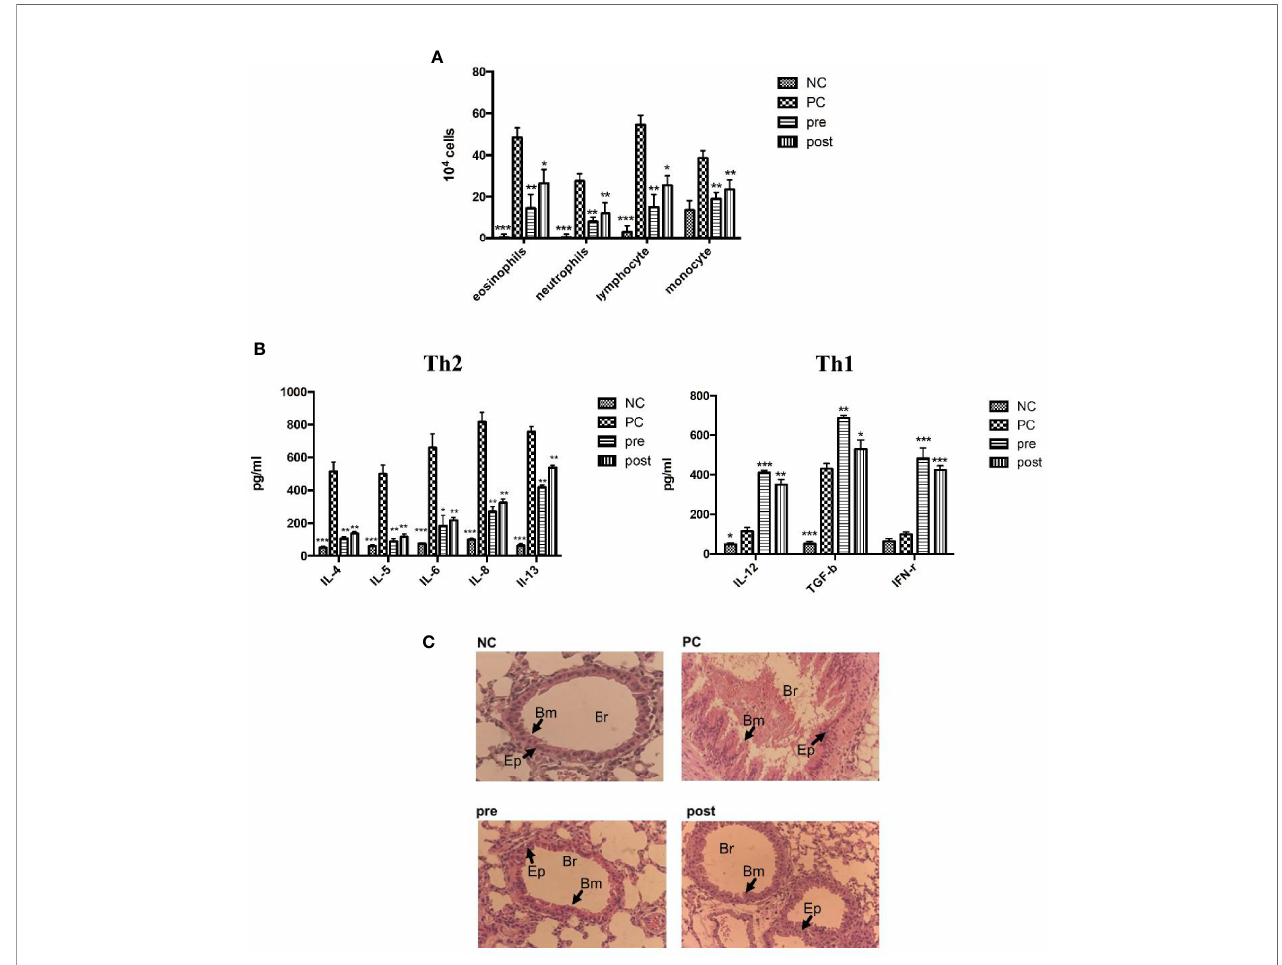
FIGURE 7 | The effects of FIP- fve treatment on the in fi ltrating in fl ammatory cells and cytokines in the BALF and the airway in fl ammation of Der m 2 -sensitized mice. (A) The in fl ammatory cells in the BALF of Der m 2 -sensitized mice were shown, and the total cells and in fl ammatory cells were counted (×10 4 ) from the BALF in millimeters by morphometric evaluations of cytospin preparations. (B) The different cytokine sets represent the Th1- and Th2-type responses. Th2-type cytokines were IL-4, IL-5, IL-6, IL-8, and IL-13 in the left panel, and Th1-type cytokines were IL-12, TGF- b , and IFN- g in the right panel. *** P < 0.001, ** P < 0.01, and * P < 0.05 compared with PC. (C) Histopathological image analysis on the airway in fl ammation in the lung tissue samples was obtained on day 28 at a magni fi cation of ×100 using a light microscope. NC group, Der m 2 -sensitized/challenged mice (PC), feeding in the fi rst 14 days (pre), and in the last 14 days (post), respectively. All lung tissue was stained with hematoxylin and eosin on the sections to evaluate the in fl ammation severity and goblet cell hyperplasia (the arrows indicated region). Br, bronchus; Bm, basement membrane; Ep,